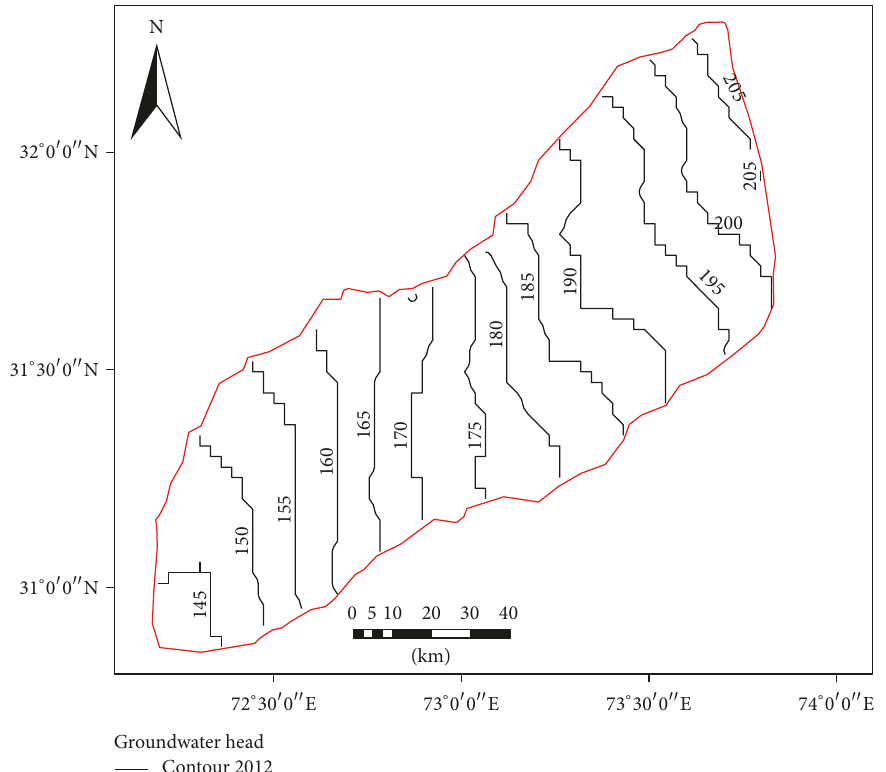
Figure 3: Spatial variation in measured groundwater levels for the year